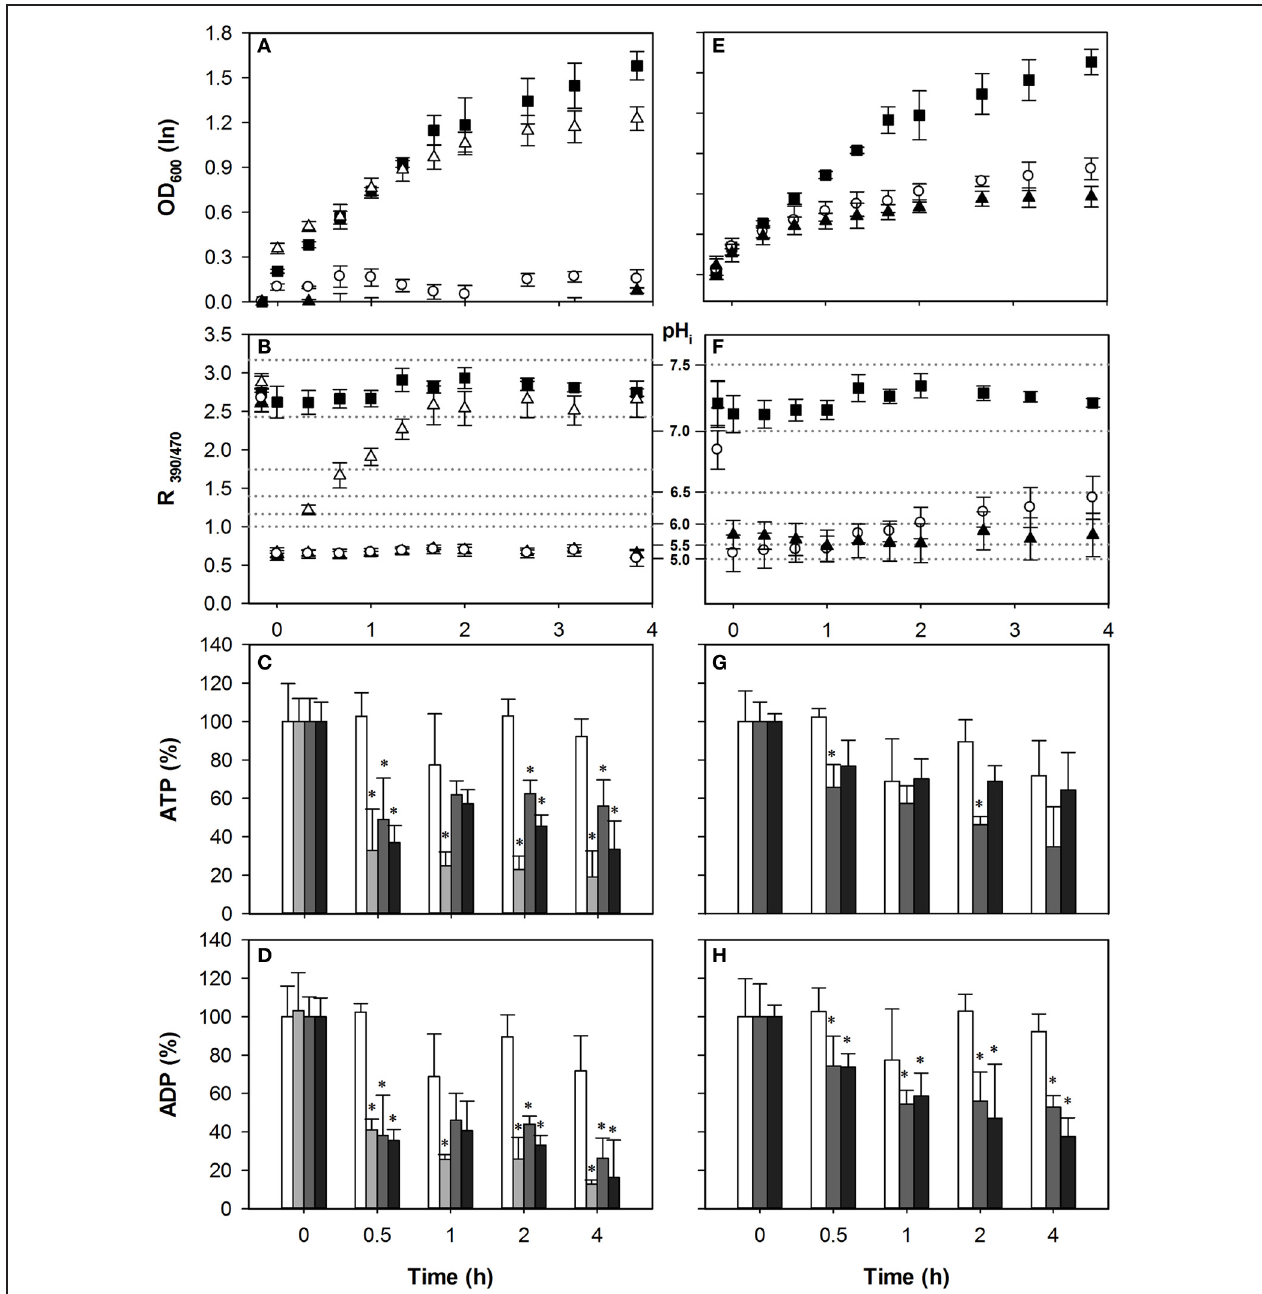
emission upon excitation at 390nm and 470nm (R 390 / 470 ) while the relevant pH i values derived from the calibration curves are also indicated. Data presented are the average of three independent cultivations and error bars represents standard deviation. An asterisk indicates significance of the difference between acid exposed and control cultures at similar time point (two-tailed t -test; P < 0 . 05). 40mM HA or 1mM HS.